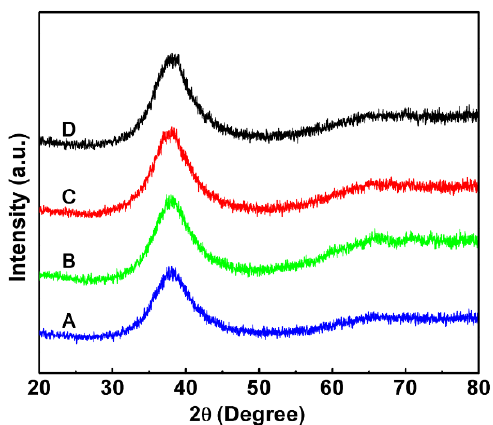
Figure 6. XRD patterns measured from the A, B, C, and D region of the smartphone frame in Figure 5b.